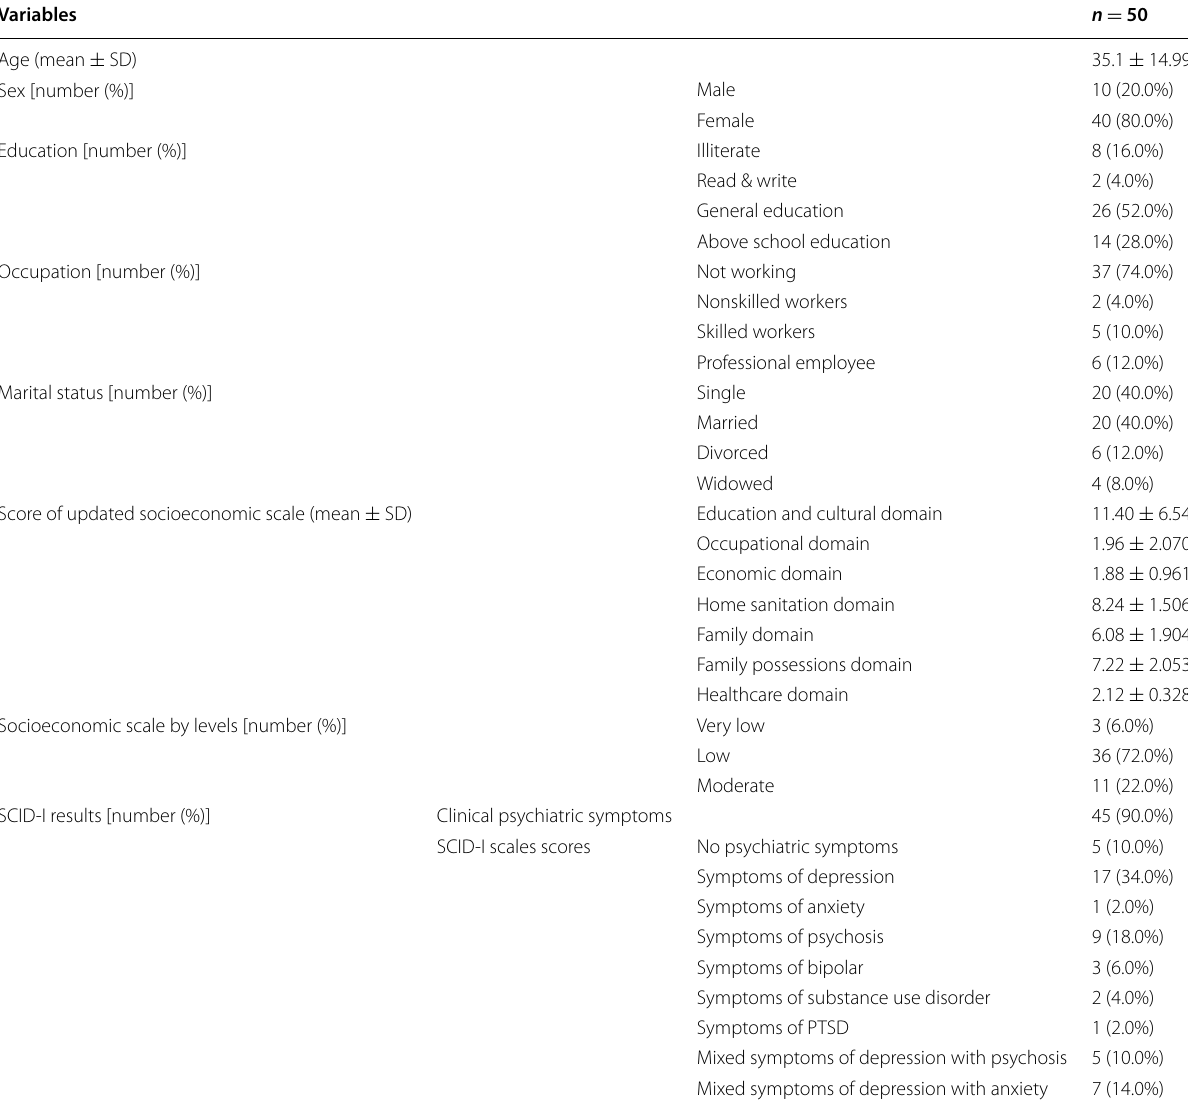
Table 1 Results of socioeconomic status and psychiatric comorbidity in the studied sample